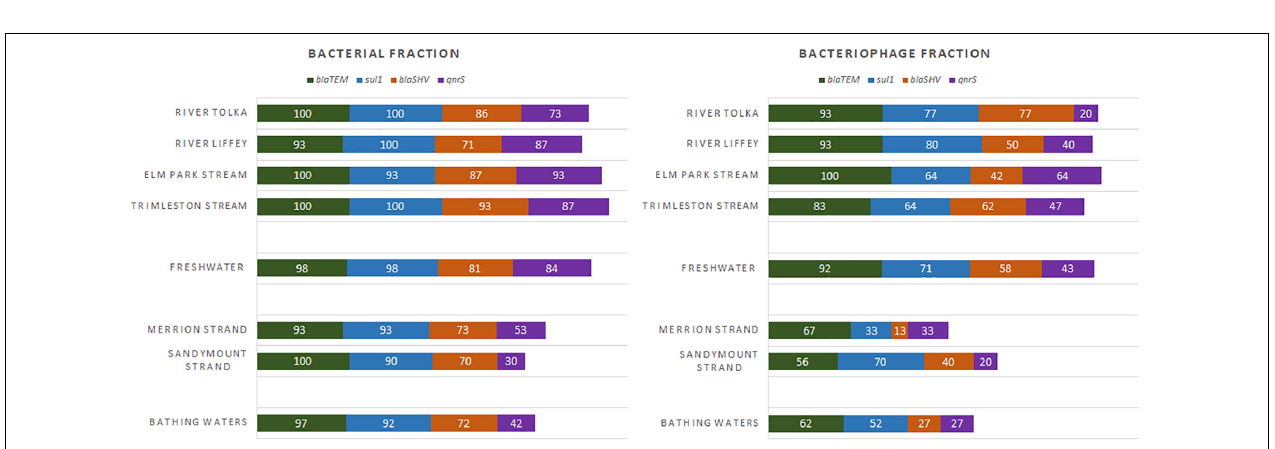
FIGURE 5 | Frequency of detection (%) for the antibiotic resistance genes in freshwater (River Tolka and Liffey, Elm Park, and Trimleston Streams) and bathing waters (Merrion and Sandymount Strands).